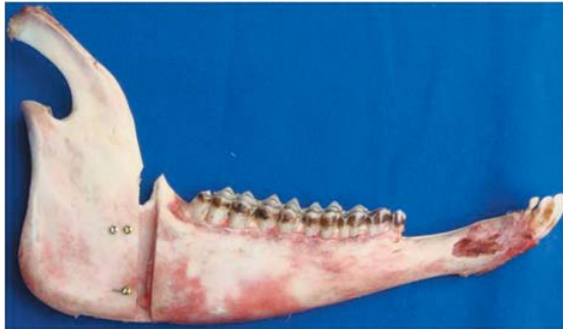
Figure 3- Inverted “L” group (Group